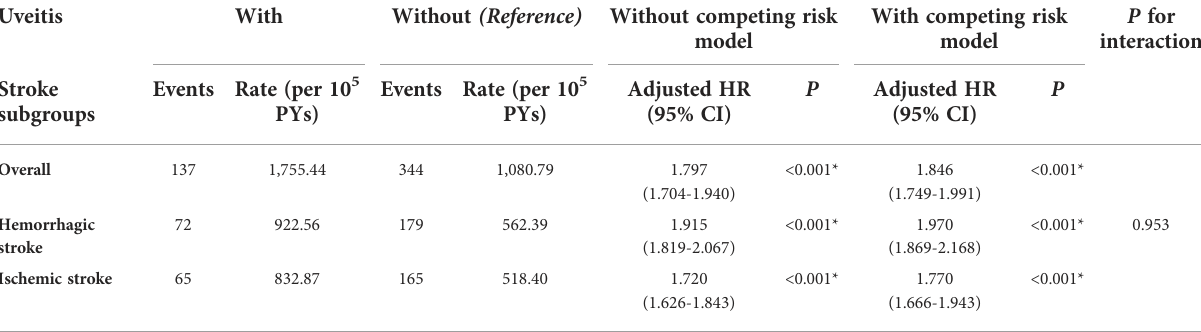
TABLE 5 Risks of stroke subgroups by using Cox proportional hazards model with/without Fine & Gray ’ s competing risk model. Uveitis